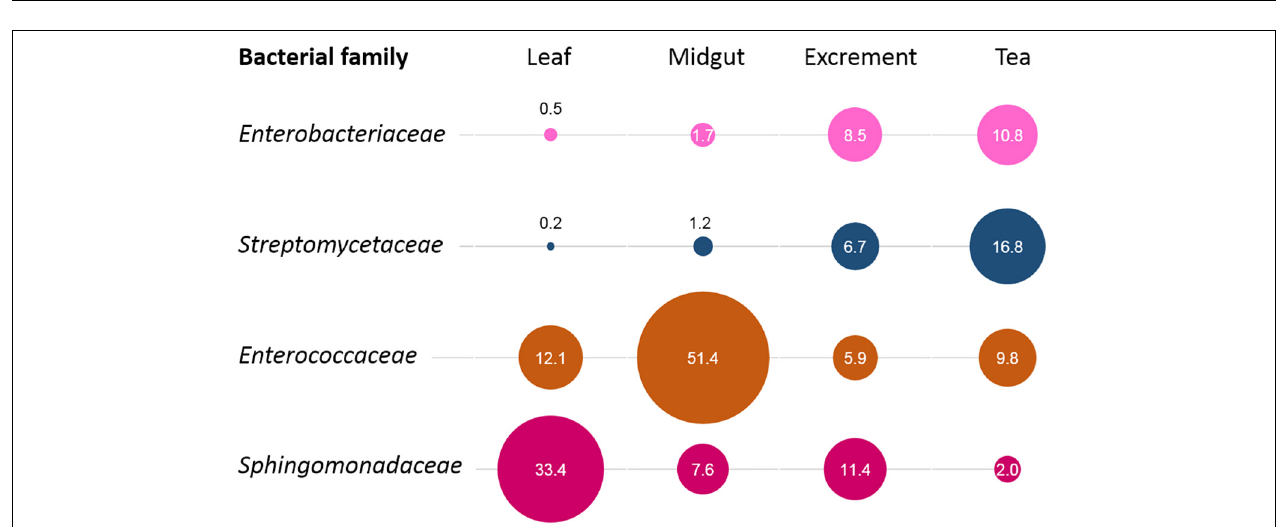
FIGURE 4 | Source tracking of bacterial constituents in insect tea. SourceTracker 0.9.5 was employed in order to identify the source of the bacterial communities that are transferred between different sample types. Transfer routes are visualized with arrows, and the percentage of assignable transferred constituents is provided for each sample pair that was analyzed. Routes were exclusively constructed to follow the direction of the production steps.